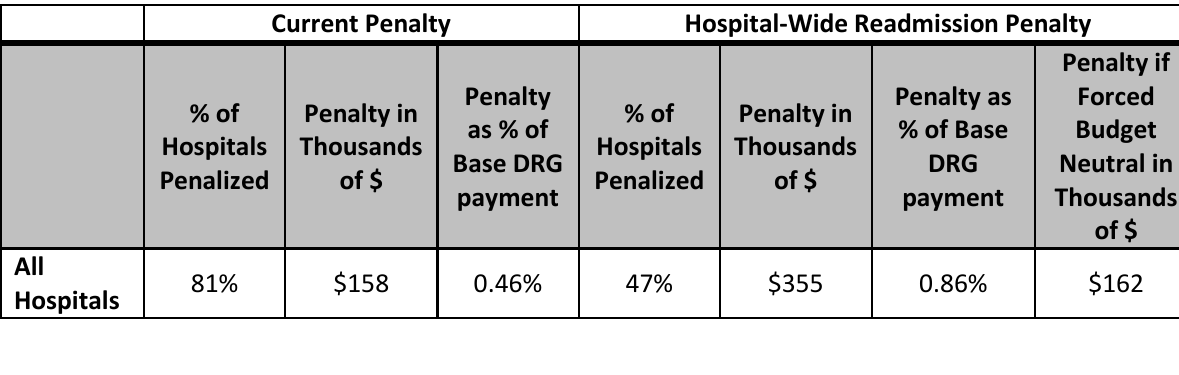
Table 5.12. Overall Impact of Moving to a Hospital-Wide Readmission